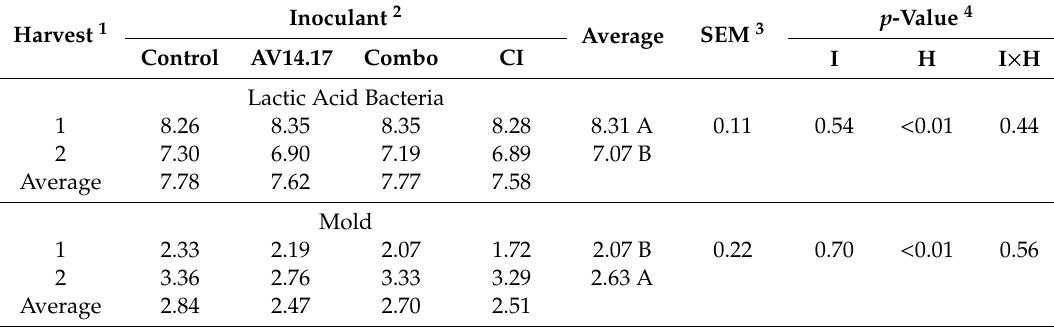
Table 5. Microbial population (log CFU / g of fresh matter) of alfalfa silage treated with microbial inoculants at two